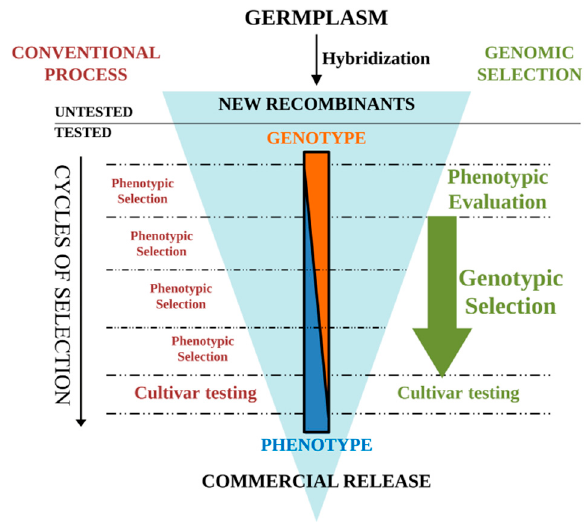
Figure 2. Comparison of genomic selection (GS) and conventional selection in tomato breeding programs. Screening of recombinant lines through GS approaches optimizes the genetic gain obtained in each selection cycle. Breeding cycles (horizontal dashed lines) are shortened by removing phenotypic evaluation of lines before training population (TRN) evaluation for the next cycle.